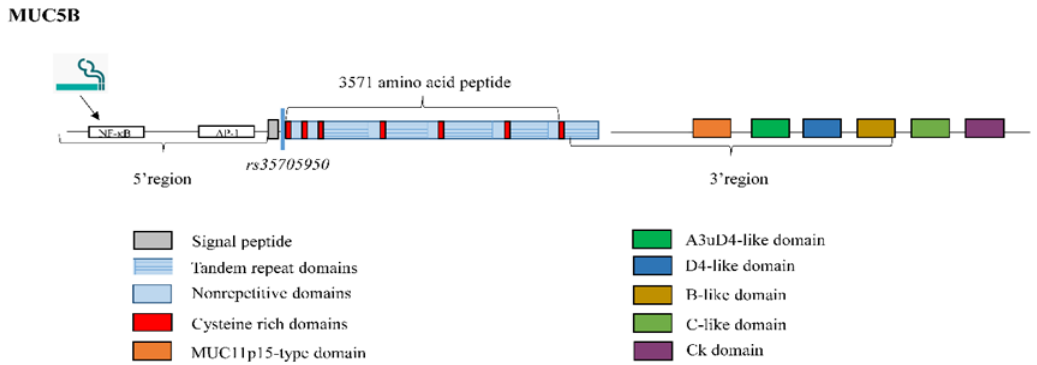
Figure 3. Structure of mucin MUC5B. The MUC5B gene has a large central exon which codes for a 3571-amino acid peptide and is constituted by tandem repeat, non-repetitive and cysteine rich subdomains. Most of these subdomains are similar to each other, thus forming four super repeat units consituded by a tandem repeat region, a unique sequence and a cysteine-rich region. 7 cysteine-rich regions are observed in total. The 3 ′ flanking region includes six subdomains (MUC11p15-type domain, A3uD4-like domain, D4-like domain, B-like domain, C-like domain, and CK domain). Nuclear factor kappa B (NF- κB) and activating protein 1 (AP -1) binding motifs have been revealed into the 5 ′ -flanking region, inducing MUC5B expression. Cigarette smoking induces MUC5B promoter activation and gene expression at least in part by nuclear factor kappa B (NF- κ B). rs35705950 is a common IPF polymorphism located 3-kb upstream of the MUC5B transcription start site.